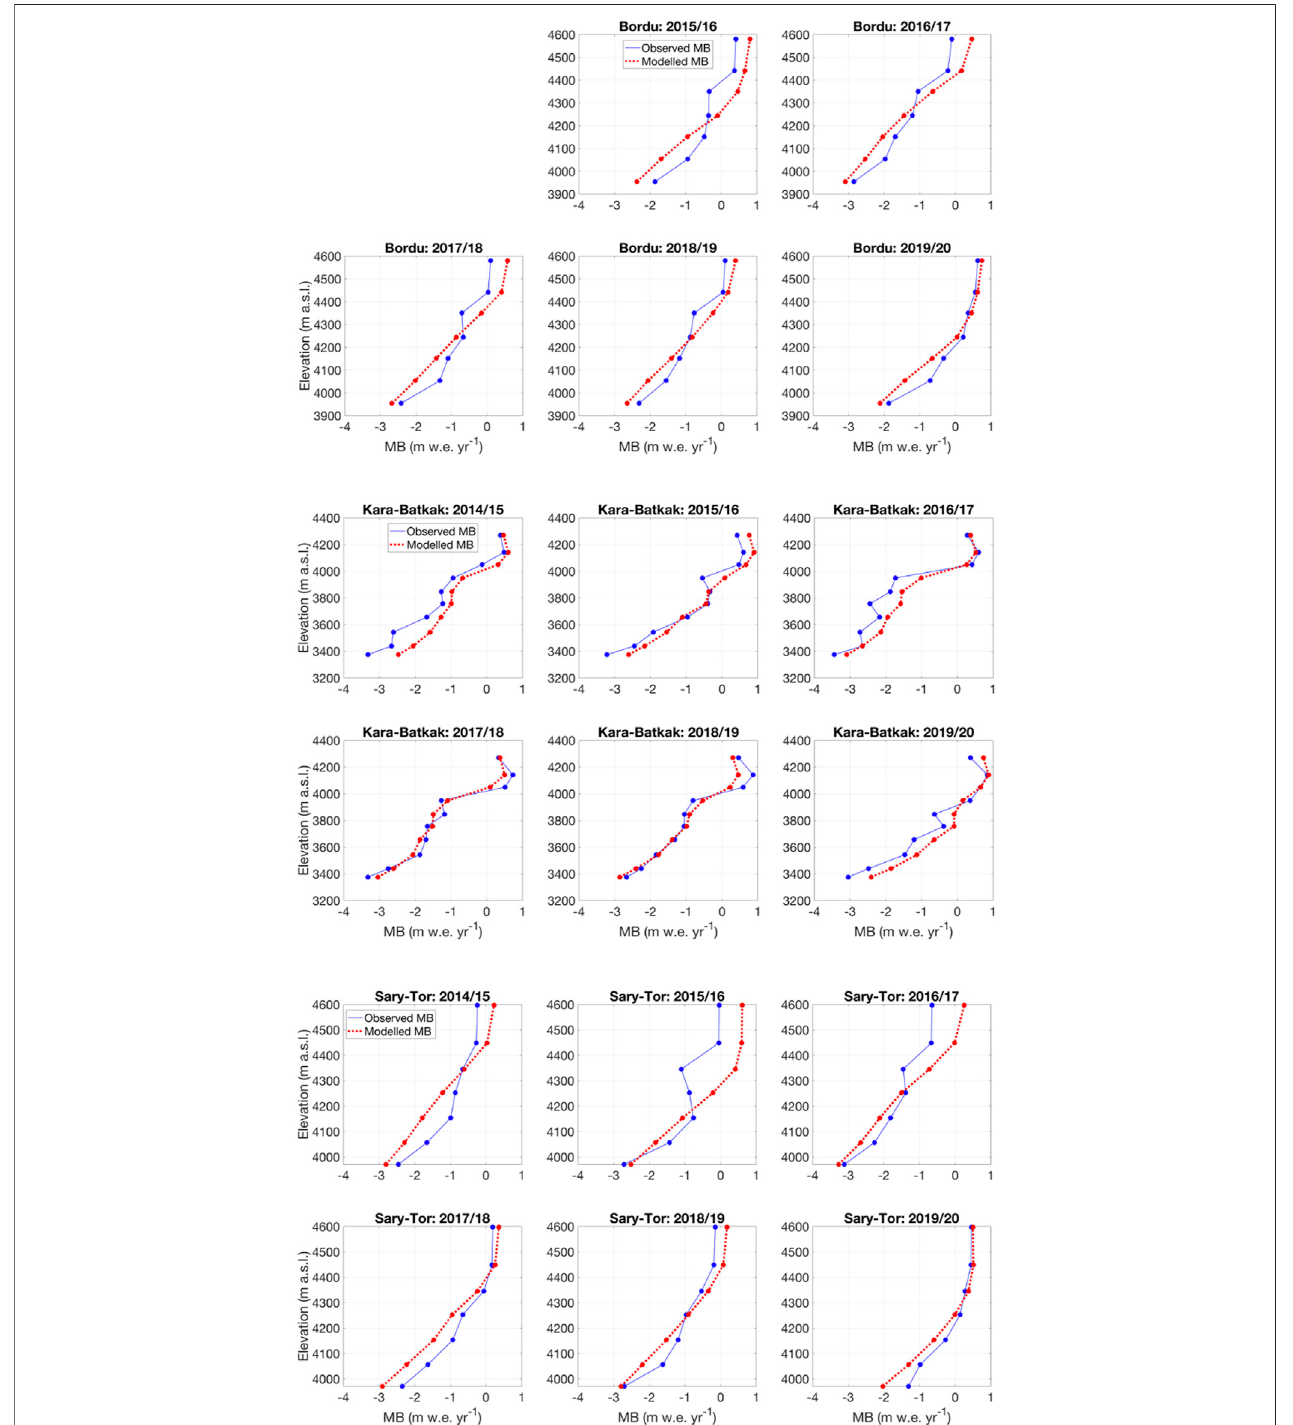
FIGURE 9 | Panels with modelled and observed mass balance (MB) in bands of 100 m with interpolations in-between for the three glaciers and for the balance years under consideration (values in m w.e. yr − 1 ).